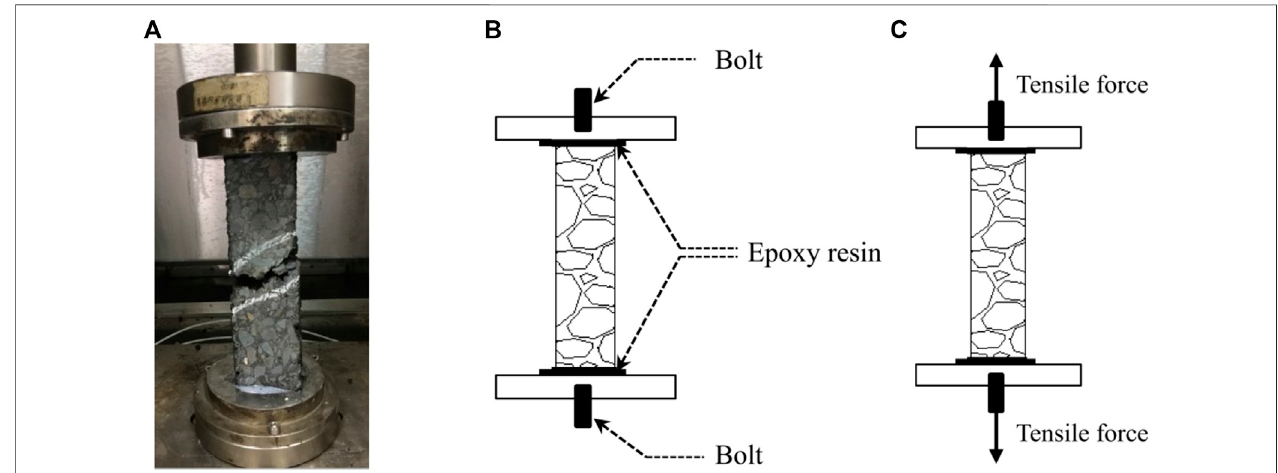
FIGURE 3 | Pull-out test equipment and schematic diagram of loading: (A) pull-out test setup; (B) specimen condition; (C) schematic diagram of loading.